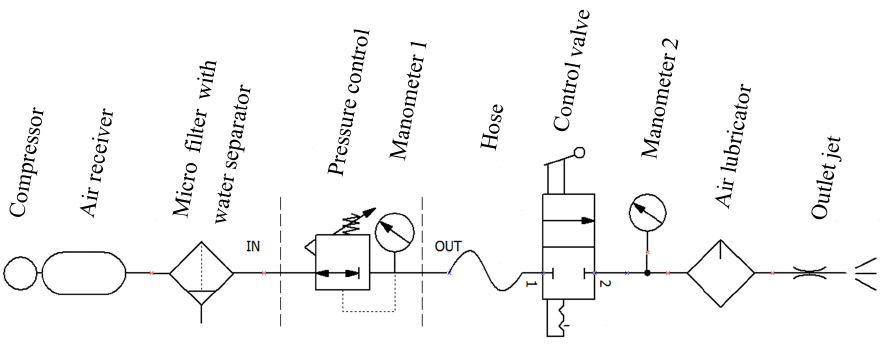
Figure 4. Pneumatic wiring diagram for experimental measurement of coating of the inner surface of an oil dispersion